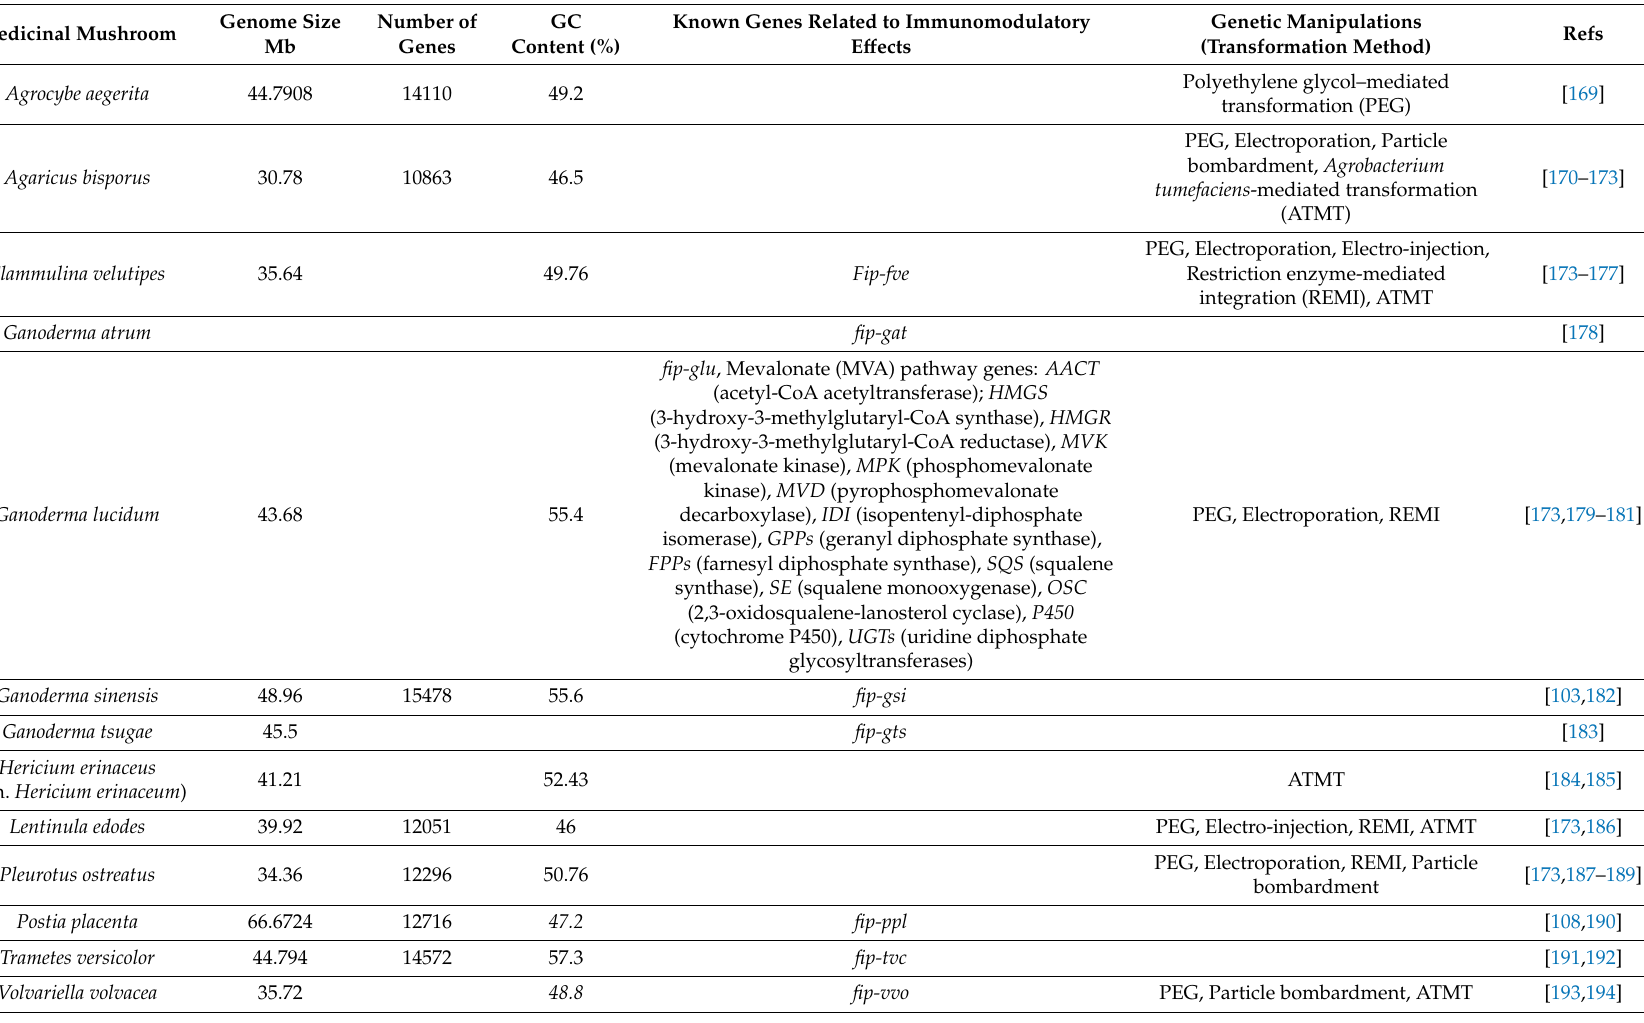
Table 6. Major genomic features of representative medicinal